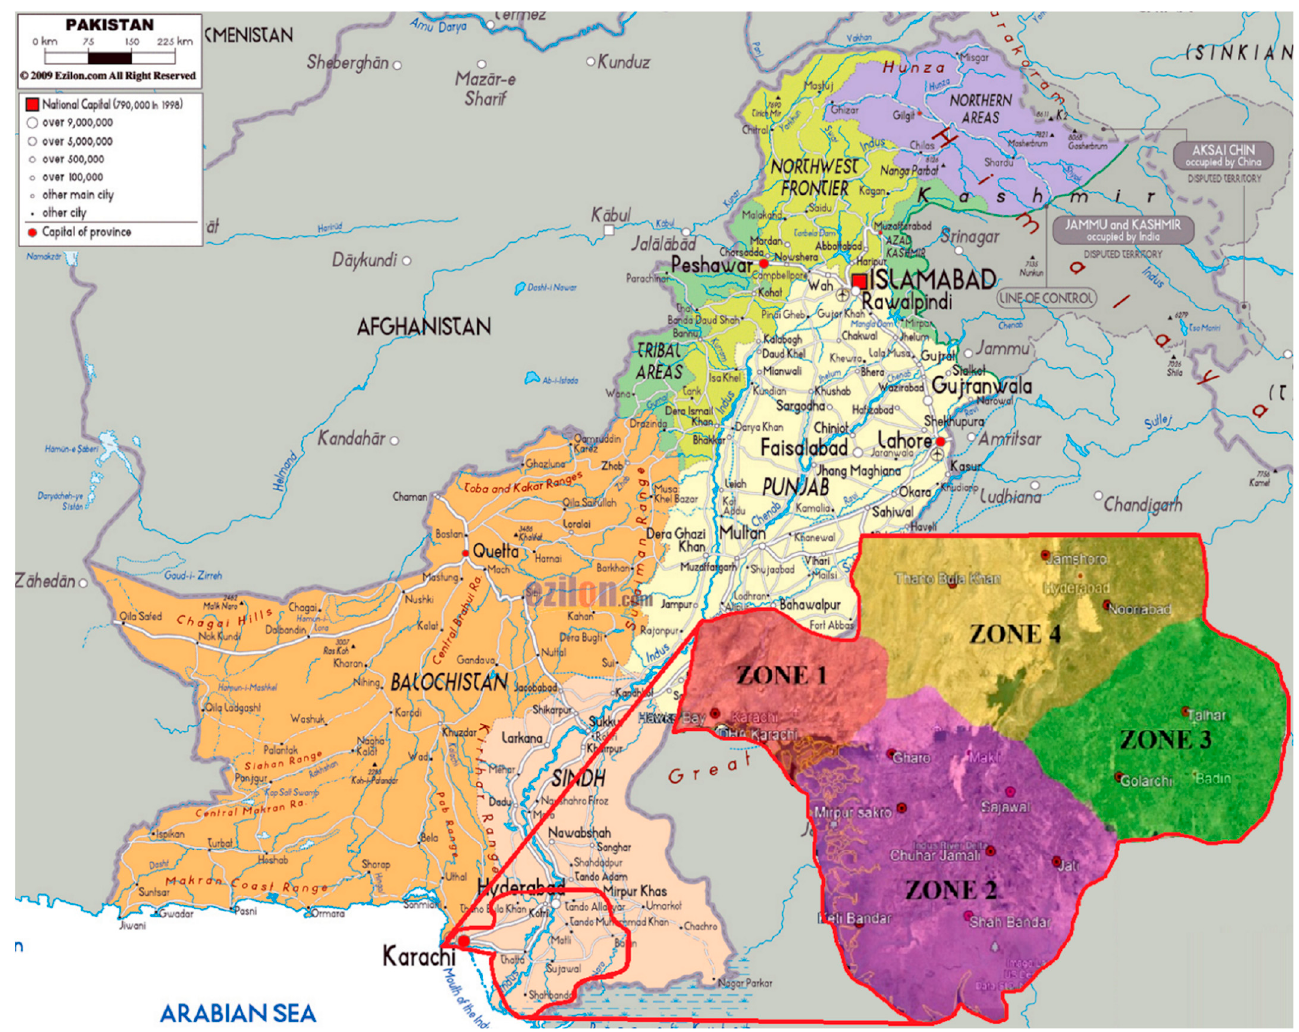
Figure 8 . Analysis of four different zones in Pakistan. Figure 8. Analysis of four different zones in Pakistan. Table 6 . Classification of four zones based on wind speed. Table 6. Classification of four zones based on wind